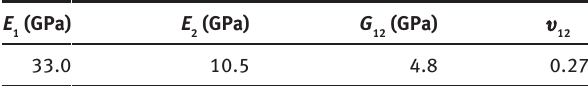
Figure 2 The free-body diagram of single-lap